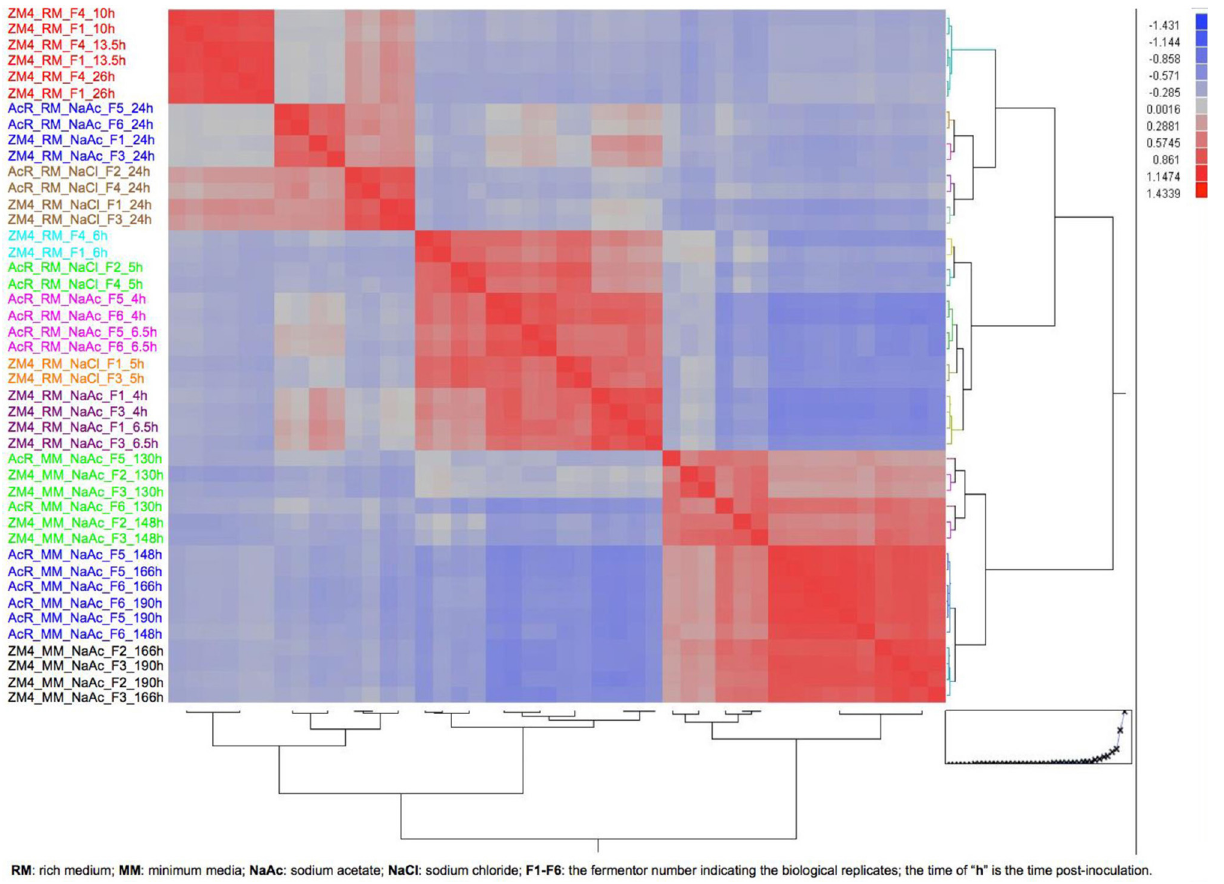
Strain-specific